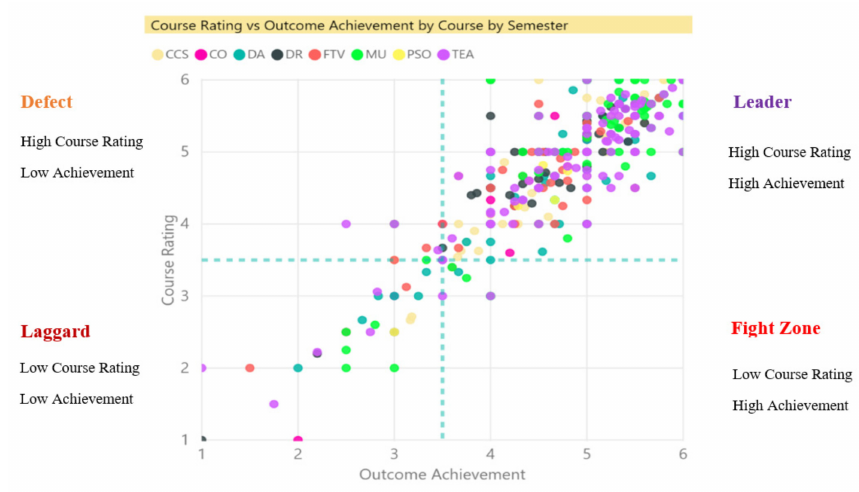
Figure 15. Outcome Achievement–Course Rating Matrix. Note: (1) In the visual, each data point represents the average course rating given by students to the question “Outcome Achievement” for a particular course. Table 5. The definition of Course Average Grade Point–Student Effort Matrix. Students paid great effort and achieved outstanding “Promised Land” learning outcomes. Students paid great effort but received discouraging results. It is “Sisyphus” worthy of reviewing whether the CILOs and assessments were too challenging. Students paid little effort but got good grades. It is worthy of “Piece of Cake” reviewing whether the CILOs and assessments were too easy. Students were disengaged and performed poorly. A holistic “Wasteland” review of the course design, learning support, and